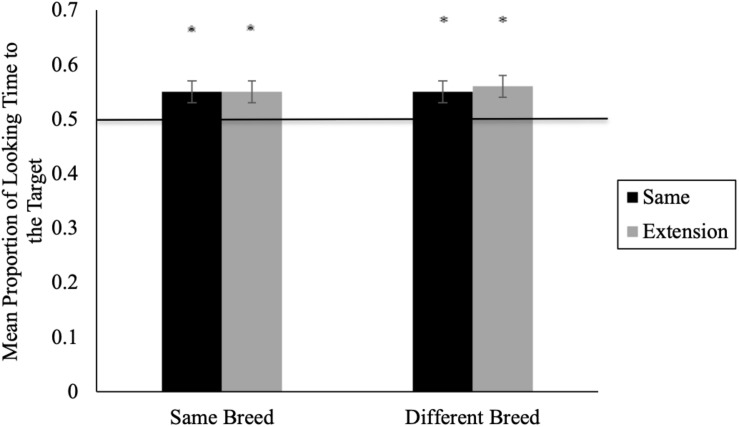
11-month-olds’ mean proportion looking time during same and extension trials for Experiment 1 (∗p < 0.05). Error bars represent standard error.